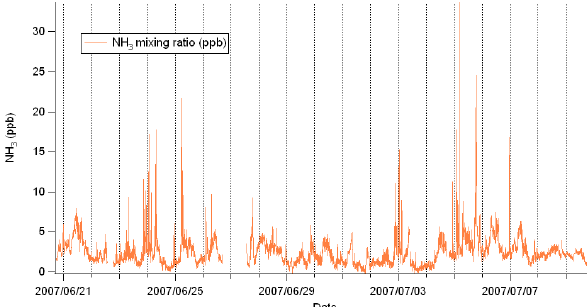
Fig. 1. Five minute averaged ammonia mixing ratios during BAQS- Met fluctuated around 2.5ppb, with higher, shorter spikes up to 30ppb mostly occurring during